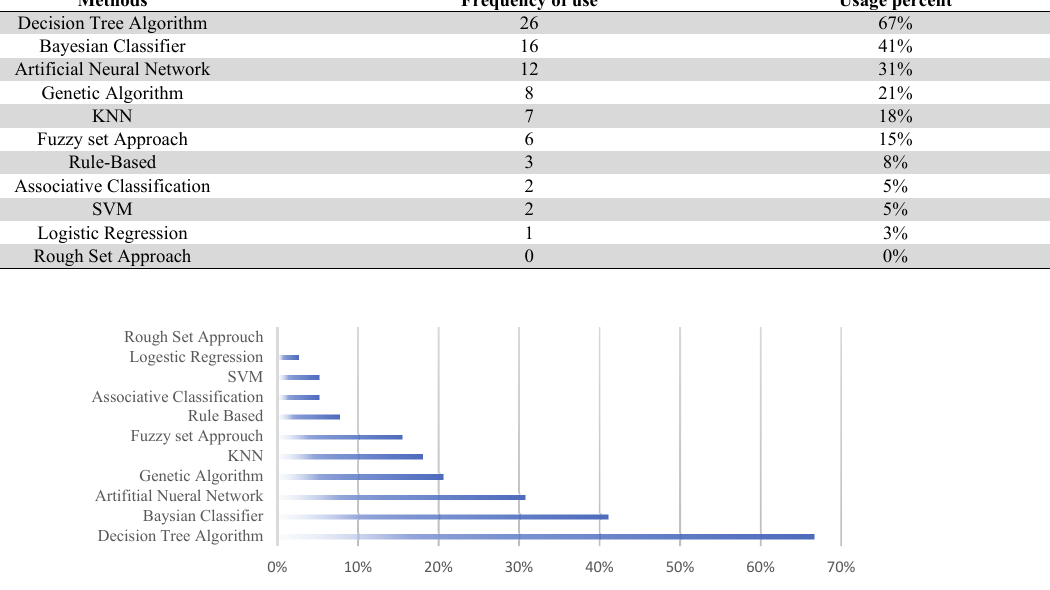
Fig. 3. Comparison of the classification